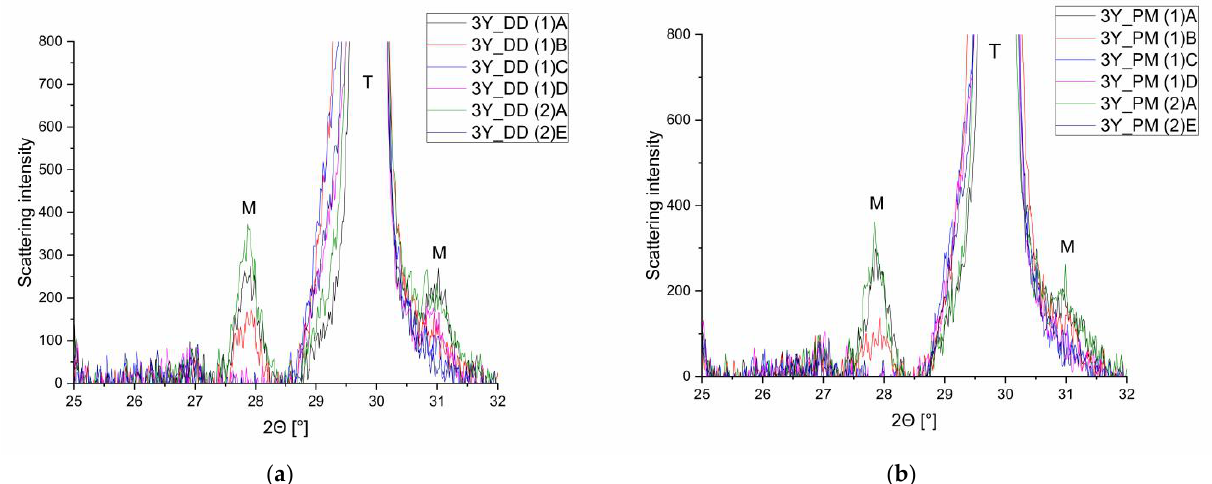
Figure 7. Comparison of the observed curves at the six different measurement positions for two 3y-TZP samples at around 30°. Their monoclinic (m) and tetragonal (t) reflexes are indicated. ( a ) 3y_DD, ( b ) 3y_PM.